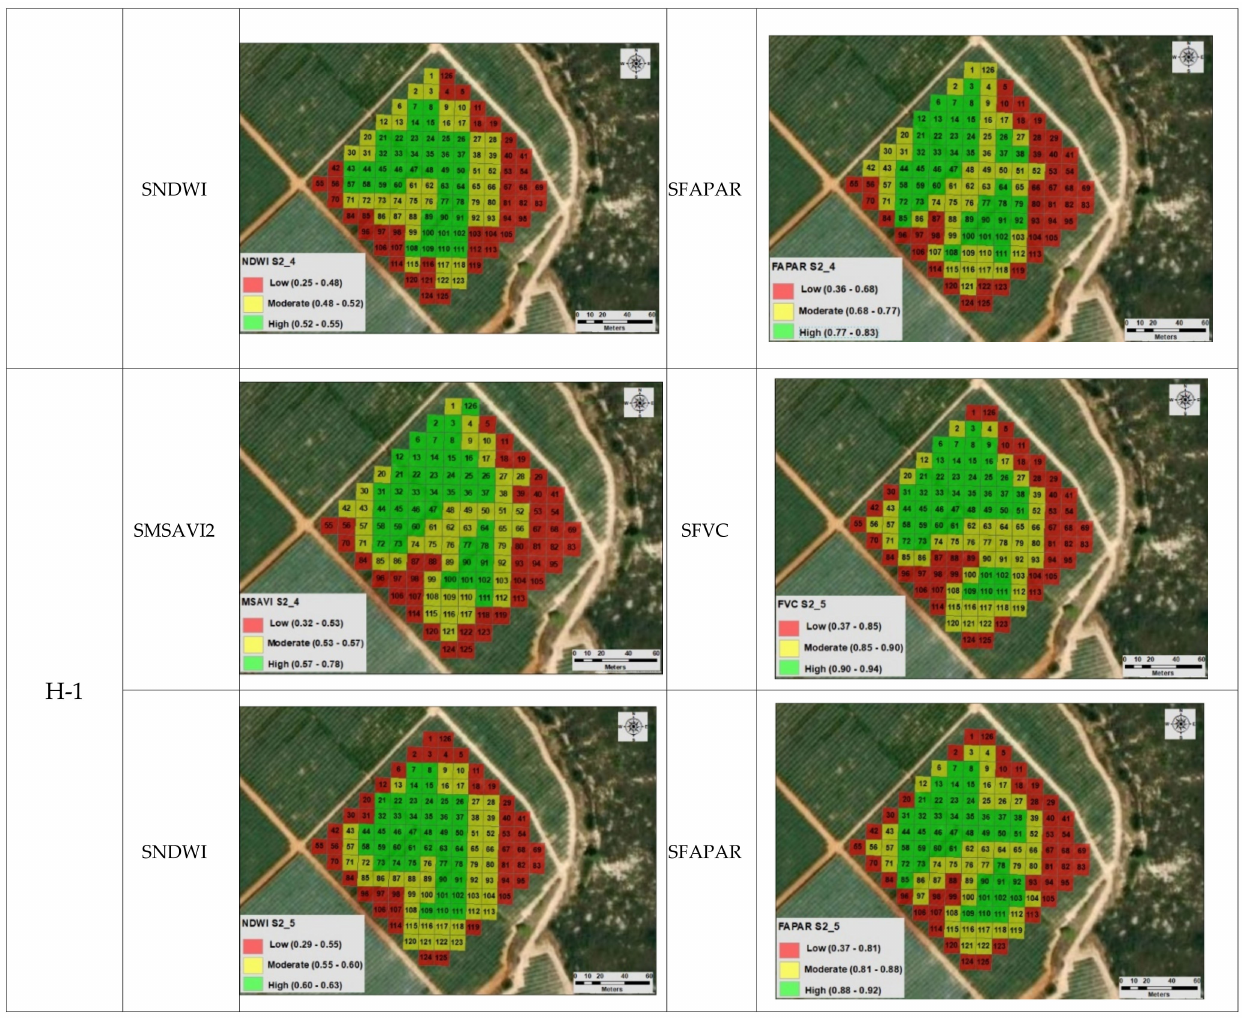
Figure 8. MSAVI2, NDWI, FVC, and FAPAR maps showing the indices values spatial variation, derived from satellite dataset for the five different stages.